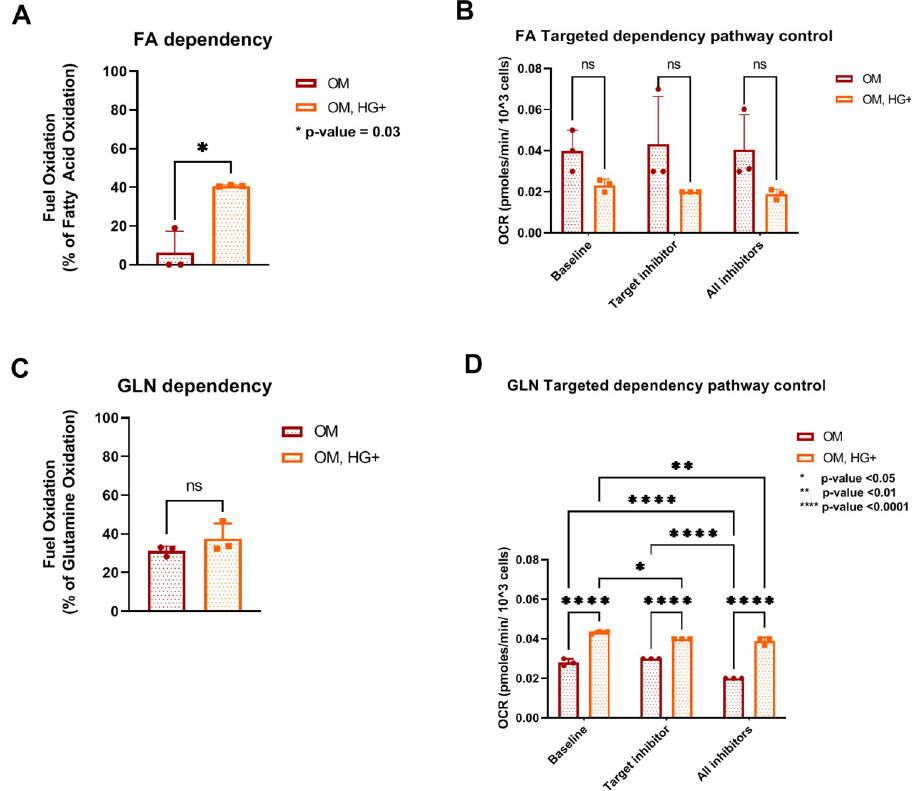
Fig 6. Osteoblast cells display FA dependency for mitochondrial oxidation under HG-induced conditions. A. FA oxidation dependency. B. FA targeted pathway dependency control. C. GLN oxidation dependency. D. GLN targeted pathway dependency control. Error bars indicate SD (standard deviation). Data were analyzed using Two-way ANOVA. N = 3 independent experiments were performed per condition. All experiments were performed in triplicates. Abbreviations: FA = fatty acid; GLN =